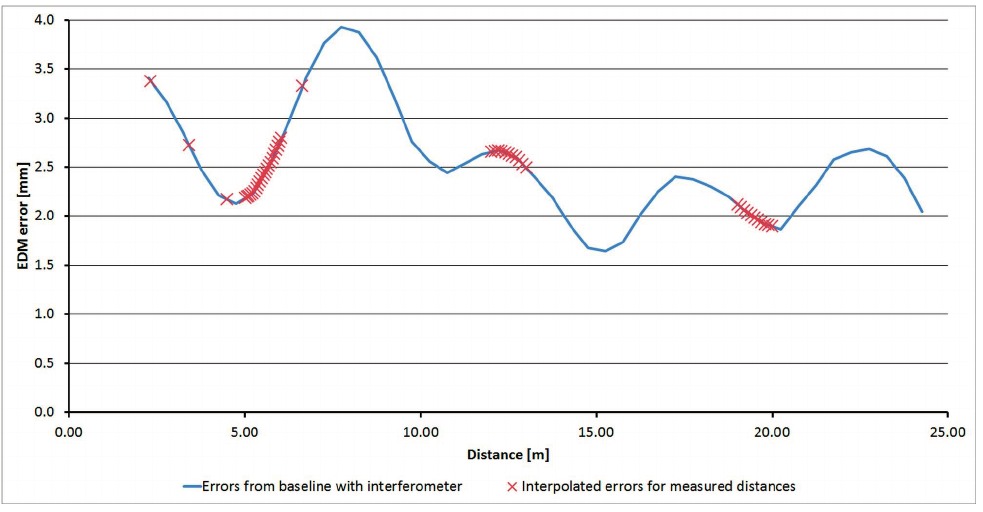
Figure 37. Interpolated corrections of the measured distances–Topcon